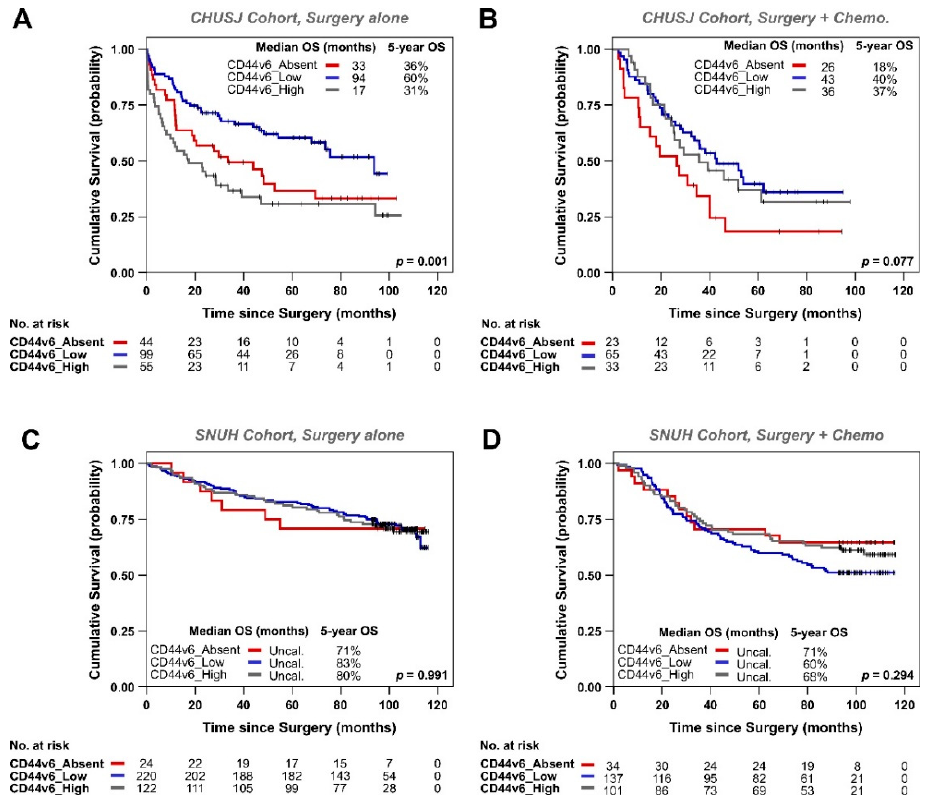
Figure 2. Kaplan–Meier estimates showing OS of GC patients according to CD44v6 status (absent, low, or high) in CHUSJ patients treated with surgery alone ( A ) or treated with surgery and conventional chemotherapy ( B ); SNUH patients treated with surgery alone ( C ) or with surgery plus conventional chemotherapy ( D ). Patients from all pTNM stages are included in this analysis. The tables below each graph indicate the number of patients still at risk in each group. Median OS and 5-year OS are shown for each patient subgroup. p -values for pairwise comparisons by the Log-Rank (Mantel–Cox test) for Figure 2A,B are shown in Tables S8 and S9, respectively.